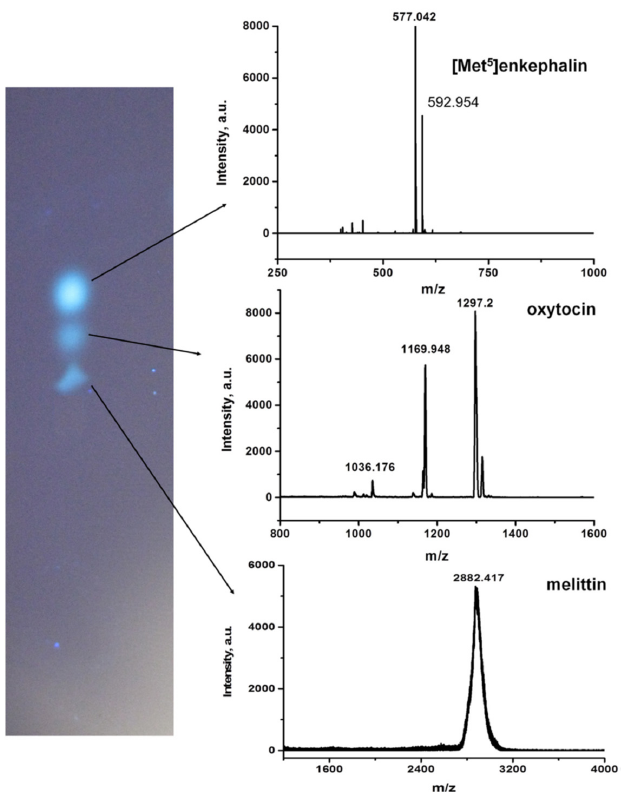
Figure 6. TLC separation of a mixture of peptides labeled with fluorescamine and MALDI-TOF-MS spectra obtained from the spots using cyano-4-hydroxycinnamic acid matrix. Reprinted with permission of Elsevier from [57].